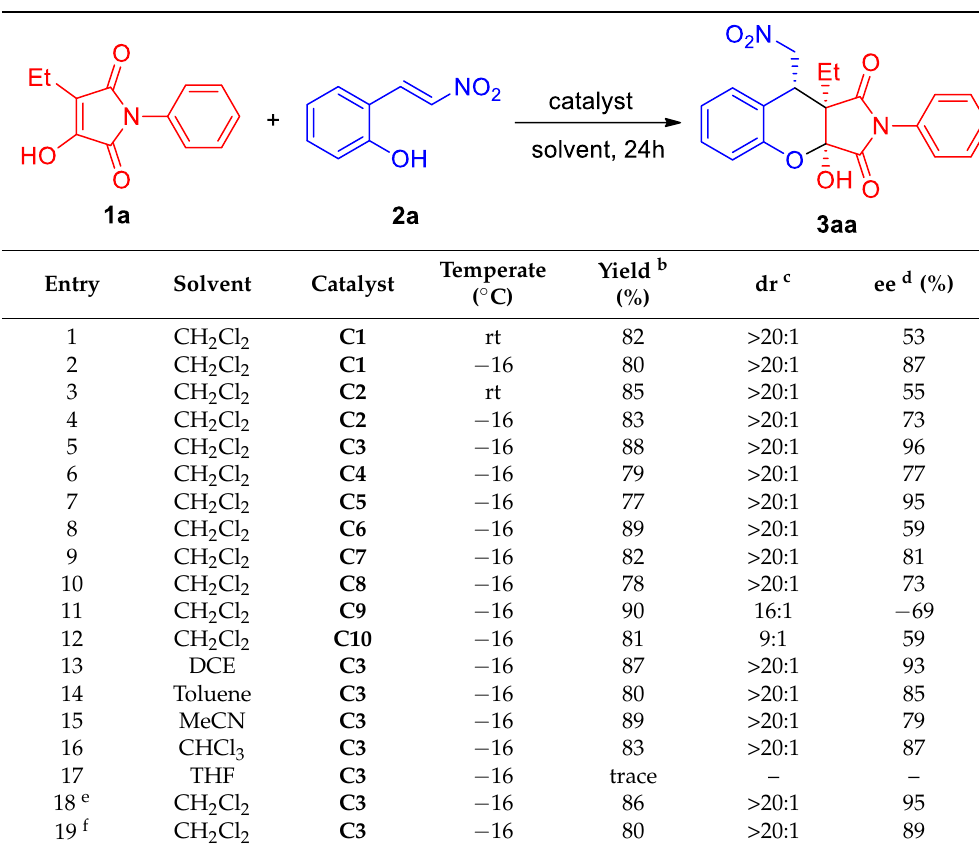
Table 1. Optimization of the reaction conditions a .